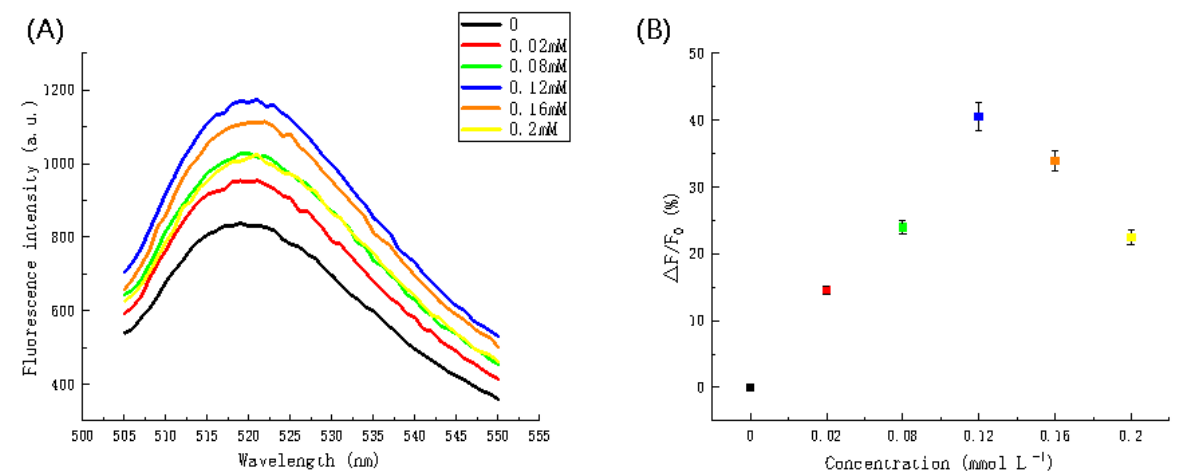
Figure 8. The impact of Mg 2+ concentration on fluorescence intensity. ( A ) Fluorescence spectra and ( B ) scatter plot of Mg 2+ concentration versus fluorescence intensity.